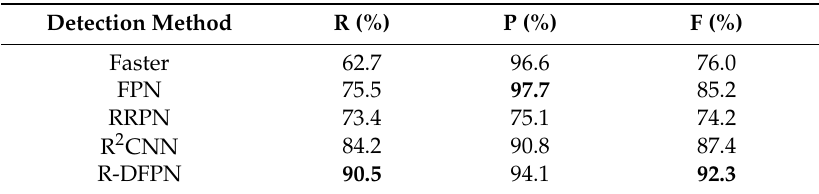
Table 3. Results under the new evaluation criteria. Bold numbers are the highest indicator values of all